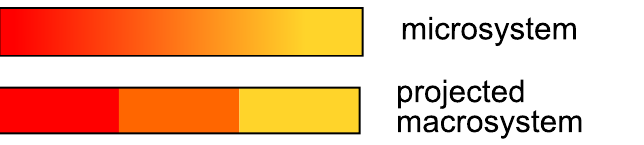
Figure 1. In the micro-system, the solution can assume a gradient of colors between red and yellow (continuum). In the macrosystem, the projection identifies only three states (red, orange, yellow). In other words, the solution has a memory because its color cannot “switch” from red to yellow within the interval τ ; if the solution is red, and it was dark red before, in the next time step it will be more likely orange-red, not yellow. Meanwhile, the particles in the solution can jump from red to yellow or to any color, regardless of the past particle color (Markov). If the Markov property were also met on the level of the projected macrosystem (the solution can be red-orange-yellow), one could find, e.g., an ordinary differential equation (a Markov process) matrix for the evolution of the concentration vectors. A solution of this system for fixed time-step τ could be represented by a matrix